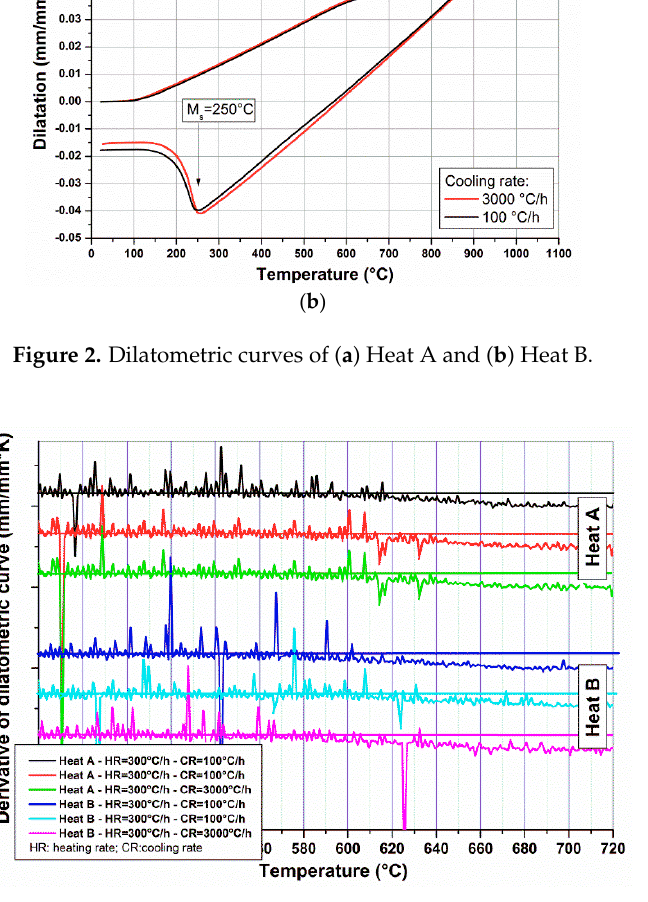
Figure 3. Derivatives of dilatometric curves of Heat A and Heat B samples. Different curves have been shifted to avoid overlapping and to allow a better comparison among them.